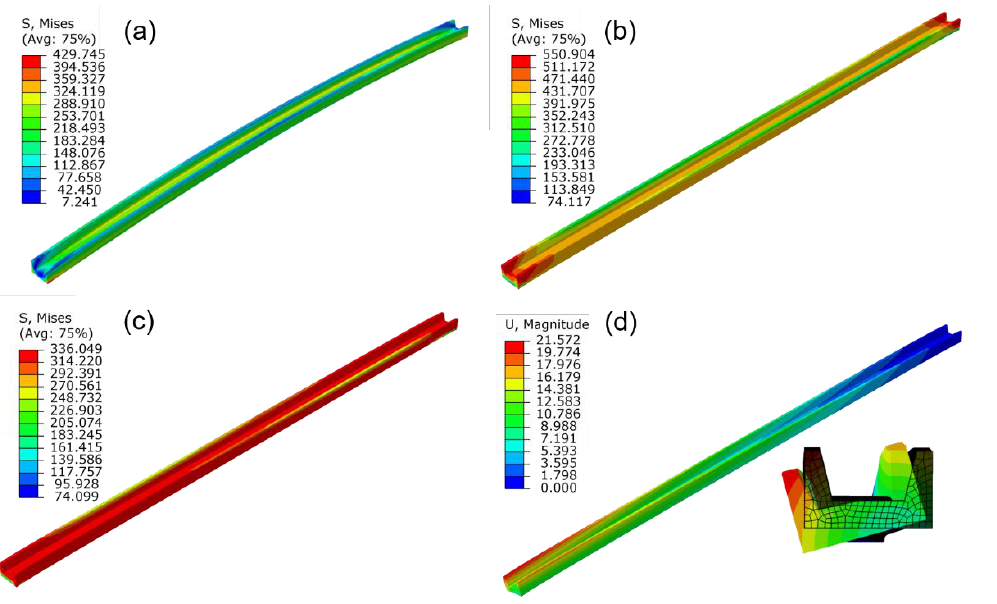
Figure 14. The simulation diagram of the straightening procedure: ( a ) twisting; ( b ) stretching; ( c ) holding; ( d ) springback.